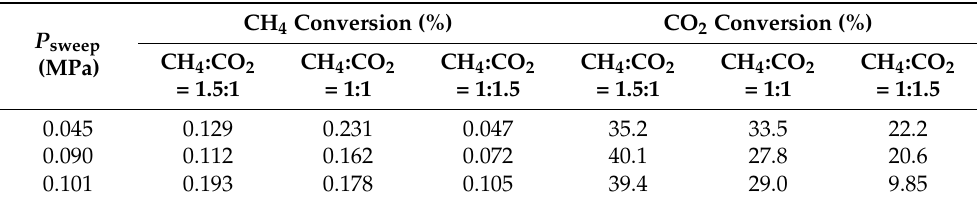
Table 7. Relationship between CH 4 conversion, CO 2 conversion and p sweep changing molar ratios of